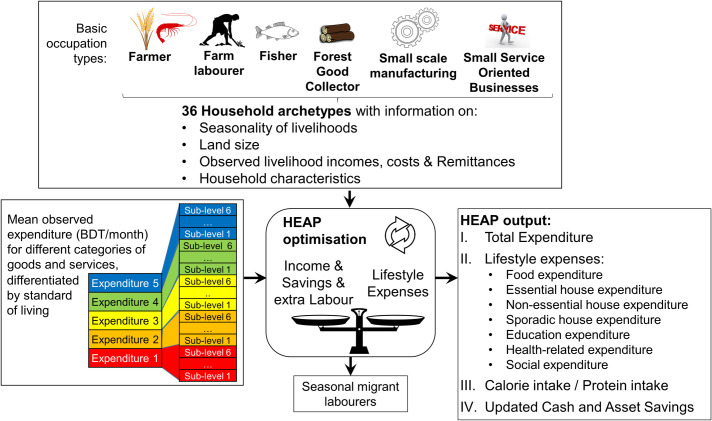
The HEAP model components.